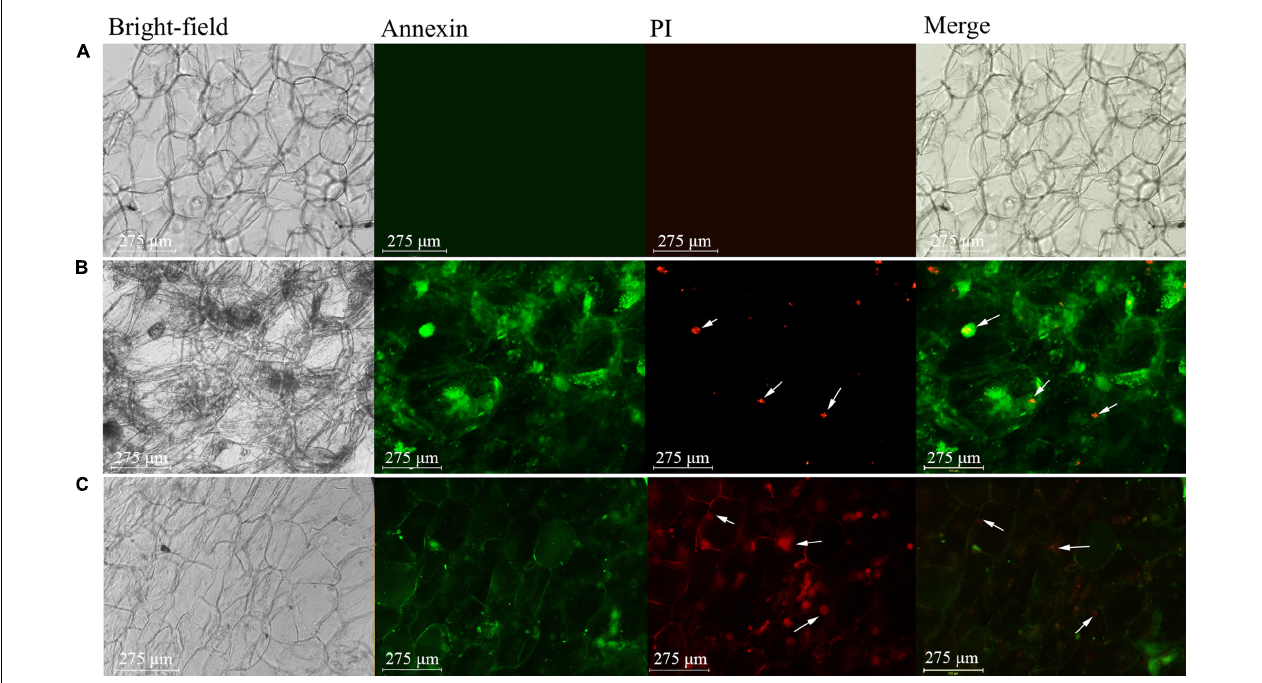
FIGURE 5 | Fluorescence microscopic analysis of apple pulp cells. The cells were double-stained with Annexin V-FITC (green) and PI (red). (A) Healthy pulp cell. (B) Pulp cells of an apple with bitter pit. (C) Pulp cells of an apple treated with dexamethasone. The arrow indicates the nucleus. Bright field, optical photos without fluorescence. Annexin, green fluorescent channel. Green fluorescence indicates that the cell membrane could be stained. PI, red fluorescent channel. Red fluorescence indicates that the chromatin in the nucleus could be stained. Merge, the overlaying of the first three photos is used to illustrate the corresponding structure of the stained fluorescent cells. The magnification of the objective of the microscope is 20